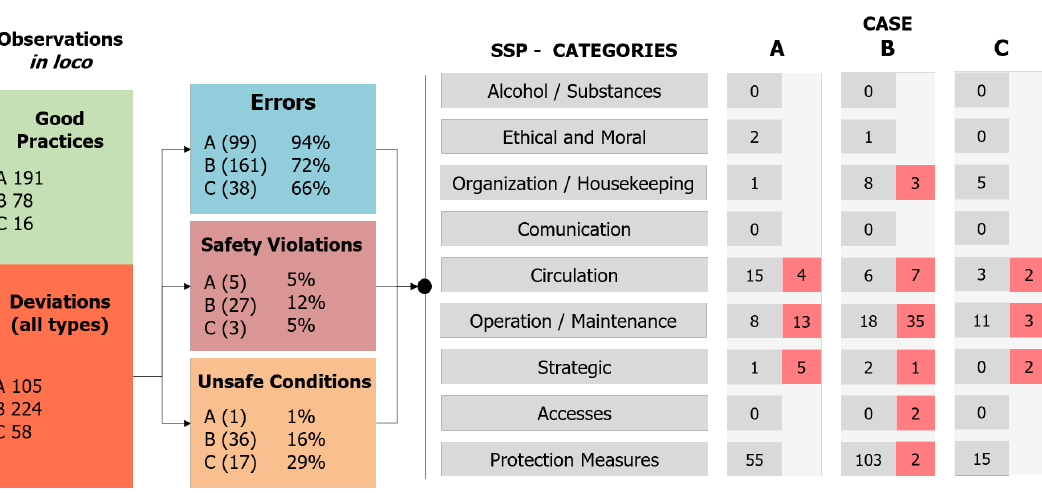
Figure 5. Classification and categorisation of Safe Behaviour Observations